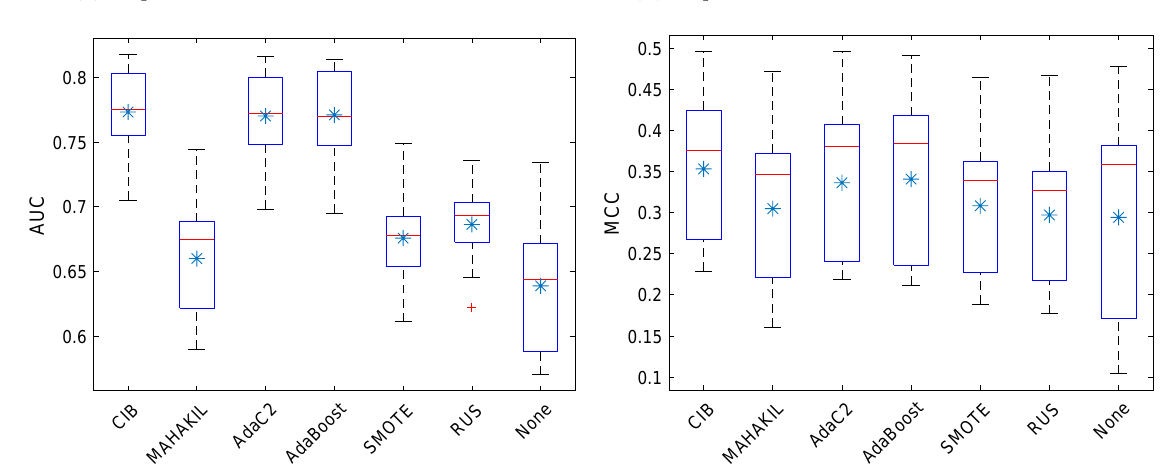
( a ) Boxplot of F 1 for all methods across all datasets.